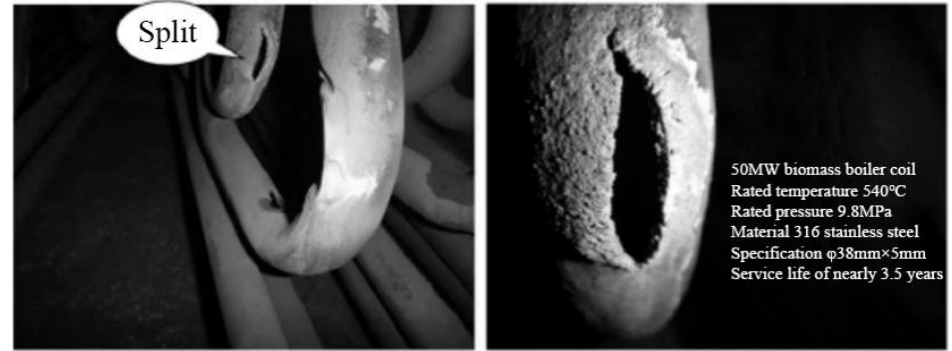
Figure 18. Rupture of coil in actual working condition.